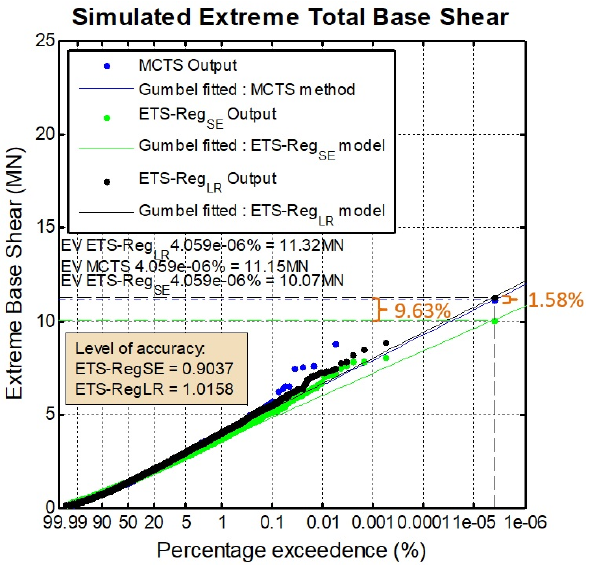
Figure 7. Comparison and validation of ETS-Reg models with the MCTS method. N = 10,000, total quasi-static base shear responses; H s = 15 m, T z = 13.75 s, and U = 0.00